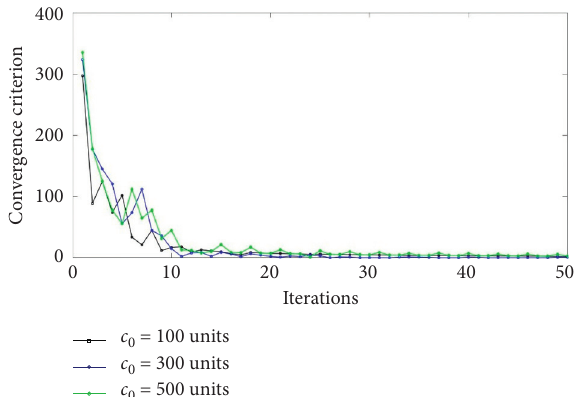
Figure 7: Convergence results for unit credit price with various extra